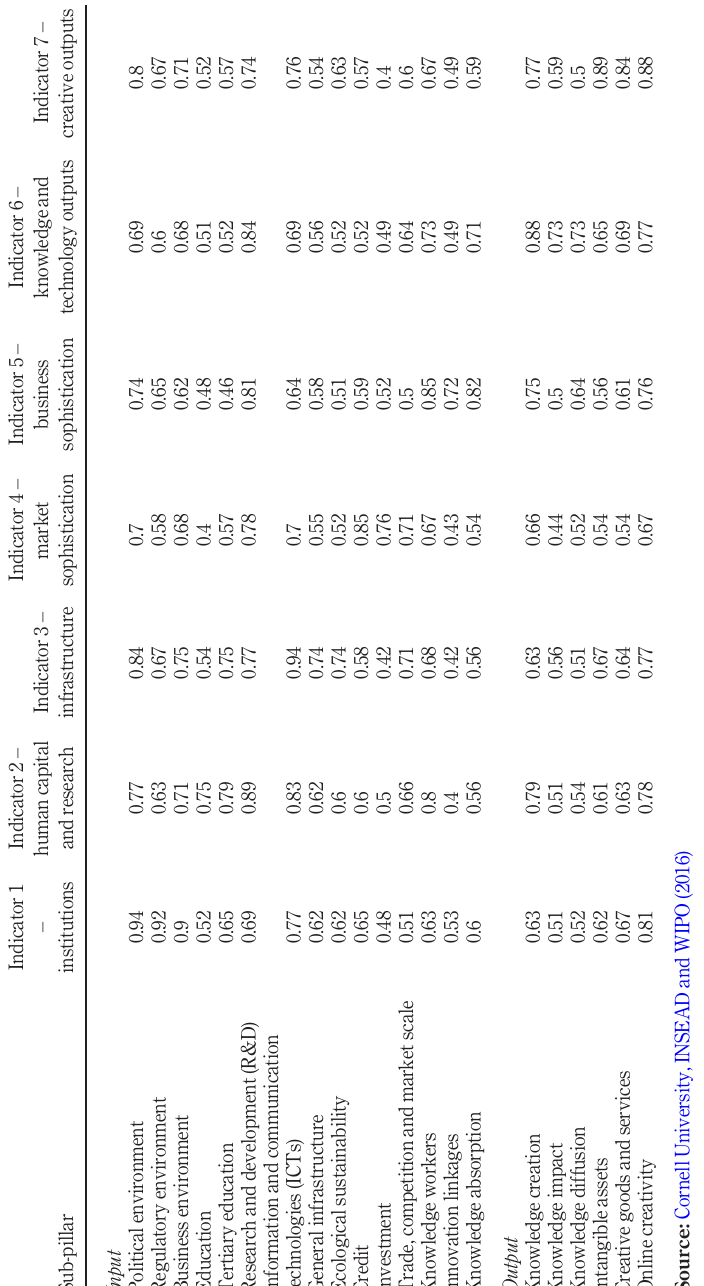
Table 2. Pearson correlation coefficient results for each sub-pillar inside innovation